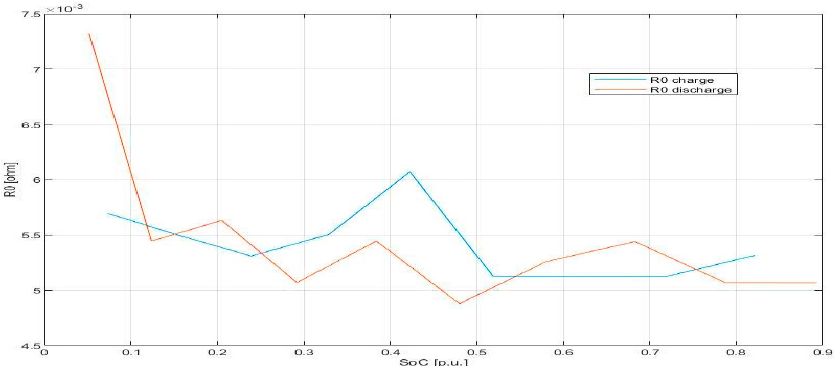
Figure 9. R 0 at different values of state of charge (SoC).